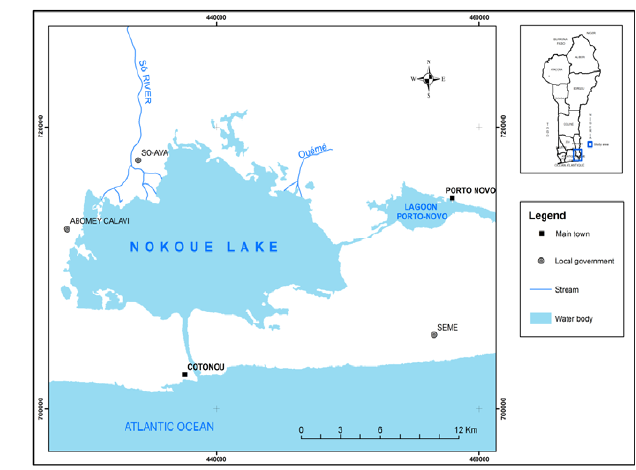
Figure 1. Location of Nokoue Lake (Benin). Source: Topographic bostom (IGN,